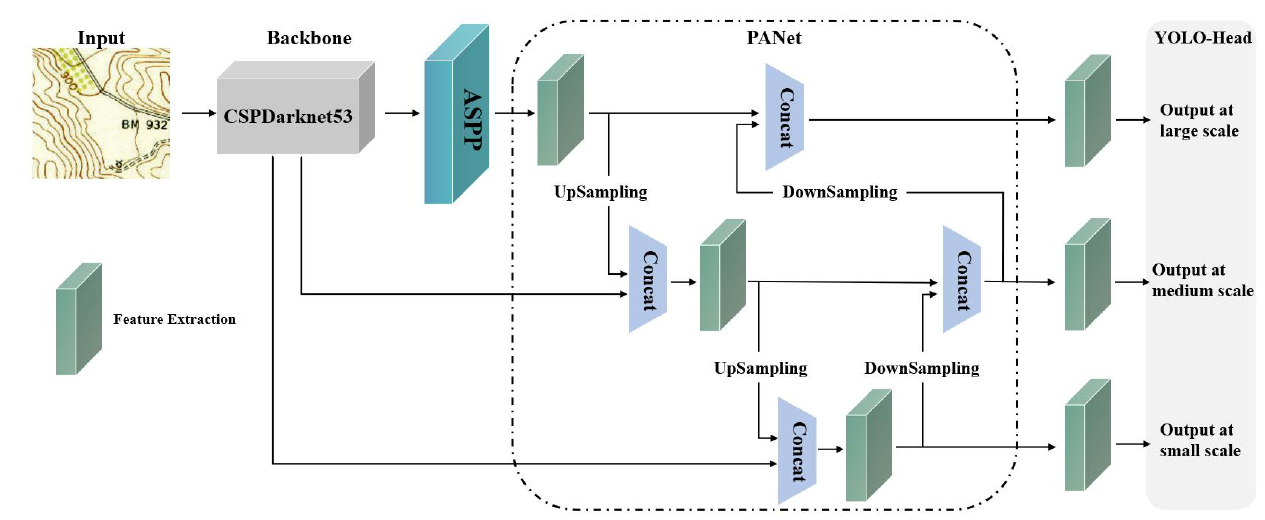
Figure 7. Overview of the YOLOv4 framework combined with ASPP. The backbone is composed of the feature extraction network CSPDarknet53, the neck is composed of PANet combined with ASPP, and the three heads are used for